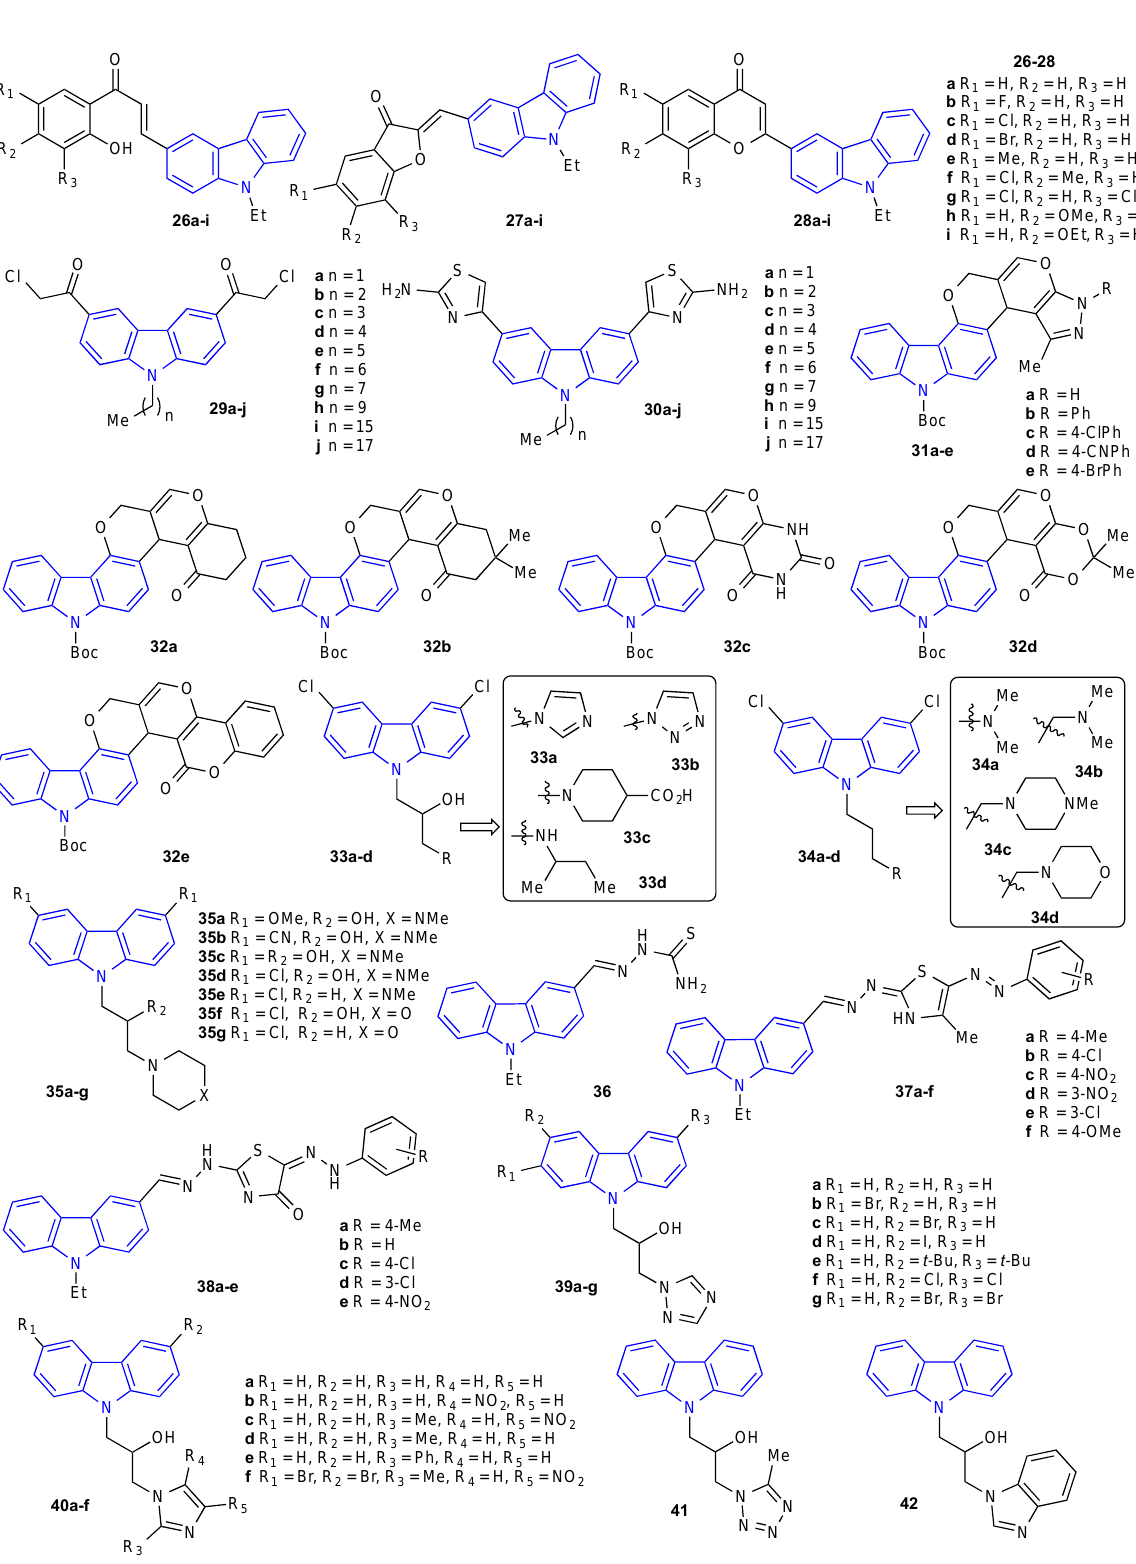
Figure 6. Structures of the reported carbazole derivatives from 2016 to 2018 . In 2020, Karpoormath et al. reported a relatively large library of carbazole hybrids ( 43a-p , 44a-l , and 45a-f ) (Figure 7). The new compounds were evaluated for their antimi- crobial activity against four bacteria ( S. aureus , B. subtilis , E. coli, and P. aeruginosa ) and four fungal ( C. albicans , C. neoformans , C. tropicalis , and A. niger ) strains [54]. Among the